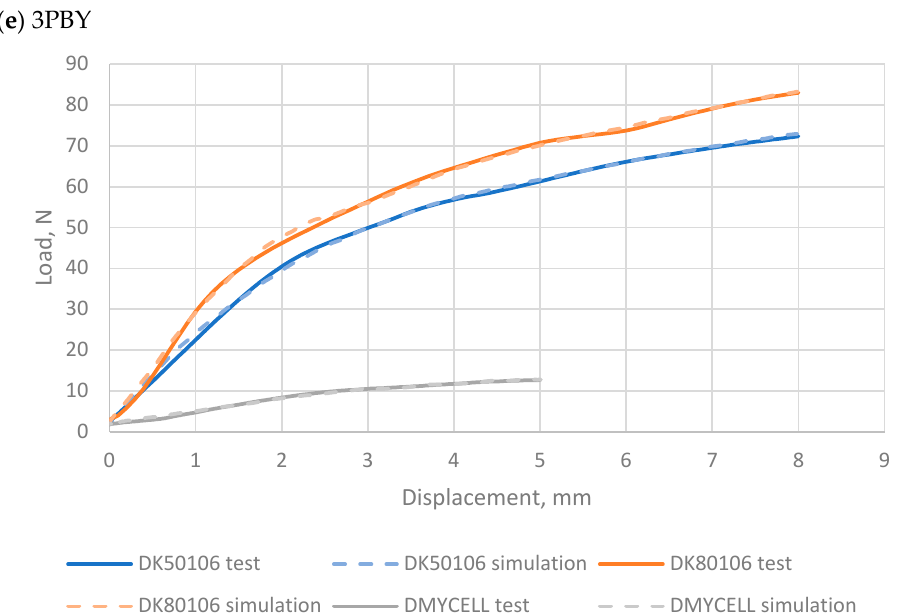
Figure 5. Comparison of simulation results from the calibrated models with test data for ( a ) Lateral compression in Z ( b ) Confined compression in X, ( c ) Confined compression in Y, ( d ) 3-point bend around X axis, ( e ) 3-point bend around Y axis. All tests conducted at 50% SoC. For each cell type and load ‐ case considered the calibrated force ‐ displacement re ‐ sponse matched well with average physical test response, deviations from the average physical test response being contained within the boundaries of the measured test to test variation. The greatest variation was found in the yielding/onset of buckling in confined compression load case. Figure 6 shows the FEM model of the Dow Kokam SLPB 50106100 cell subject to the three main load cases of lateral compression, in ‐ plane confined compression and three ‐ point bend. The original and deformed meshes are visible, demonstrating the stability of the model.